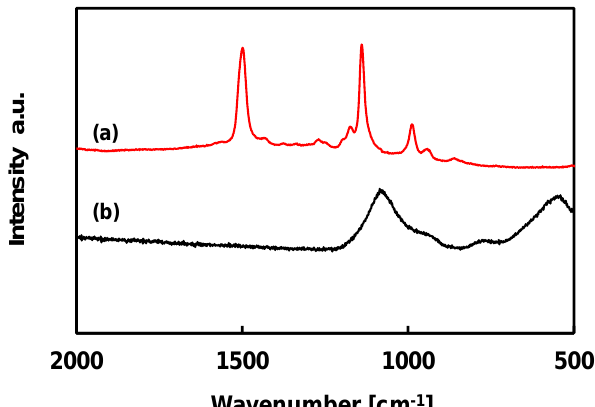
Figure 3. The results of Raman analysis of the obtained biofilm. (a) Biofilm formation after 10 days on glass substrate, (b ) Bared−glass substrate.